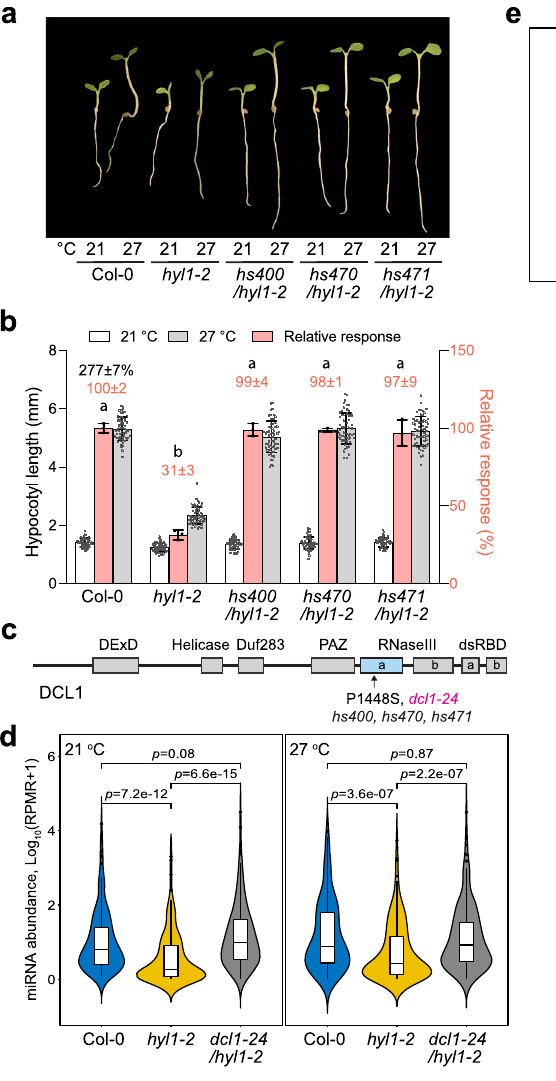
the relative responses represent the s.d. of three biological replicates. The centers of all error bars indicate the mean values. c Schematic illustration of the domain structure of DCL1 and the position of the suppressor dcl1-24 mutation. d Violin plotsshowingthe relativeglobalmiRNAlevelsinCol-0, hyl1-2 ,and dcl1-24/hyl1-2 at 21°C (left) and 27°C (right). The miRNA levels were quanti fi ed relative to the respective reads from small RNA fragments derived from 45S rRNA. RPMR, reads permillionofrRNAreads.Intheboxandwhiskerplots,theboxesrepresentthe25% to 75% quantiles, and the bars are equal to the median. Statistical signi fi cance was analyzedusingatwo-tailedStudent ’ st-test, n =3independentbiologicalreplicates. e Heatmap showing the relative levels of the 56 miRNAs downregulated in hyl1-2 and rescued in dcl1-24/hyl1-2 at 27°C. The source data underlying the hypocotyl measurements in ( b ) are provided in the Source Data fi